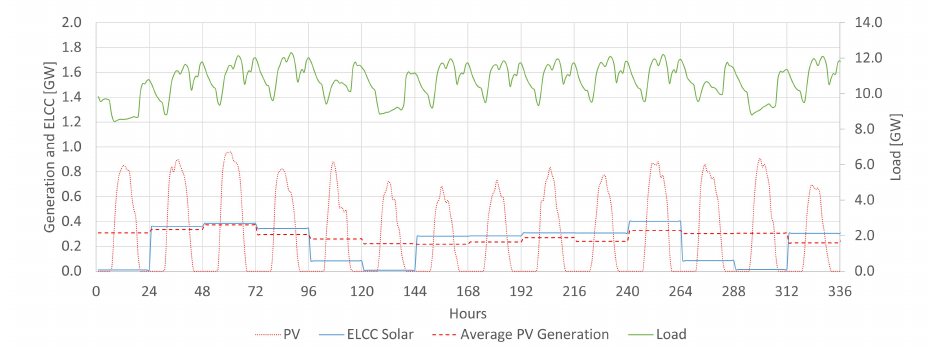
Figure 18. Load, PV generation, ELCC in an hourly basis for the first two weeks of 2019 for the Northeast subsystem.